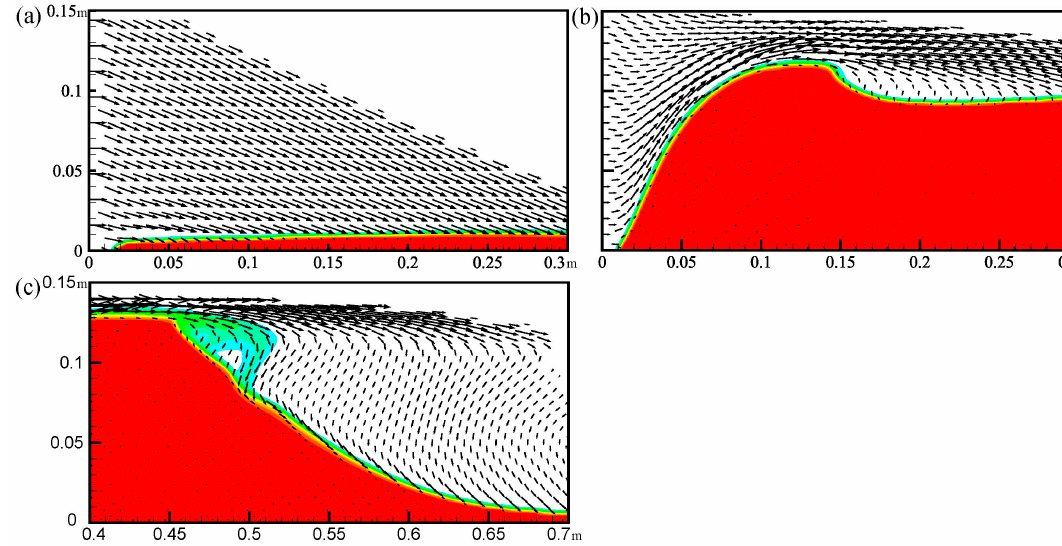
Figure 3. The velocity vector charts of the proppant in the primary fracture, ( a ) the proppant bed height is about 0.1 EPH, ( b ) the proppant bed height is about 0.75 EPH, and ( c ) the proppant bed height has reached the EPH. The red part represents the proppant bed. The length and height of the primary fracture is about 1 m and 0.15 m, respectively. The horizontal coordinates indicate the distance from the entrance of the cross fractures. (Case 3 in Table A1). EPH: equilibrium proppant height.